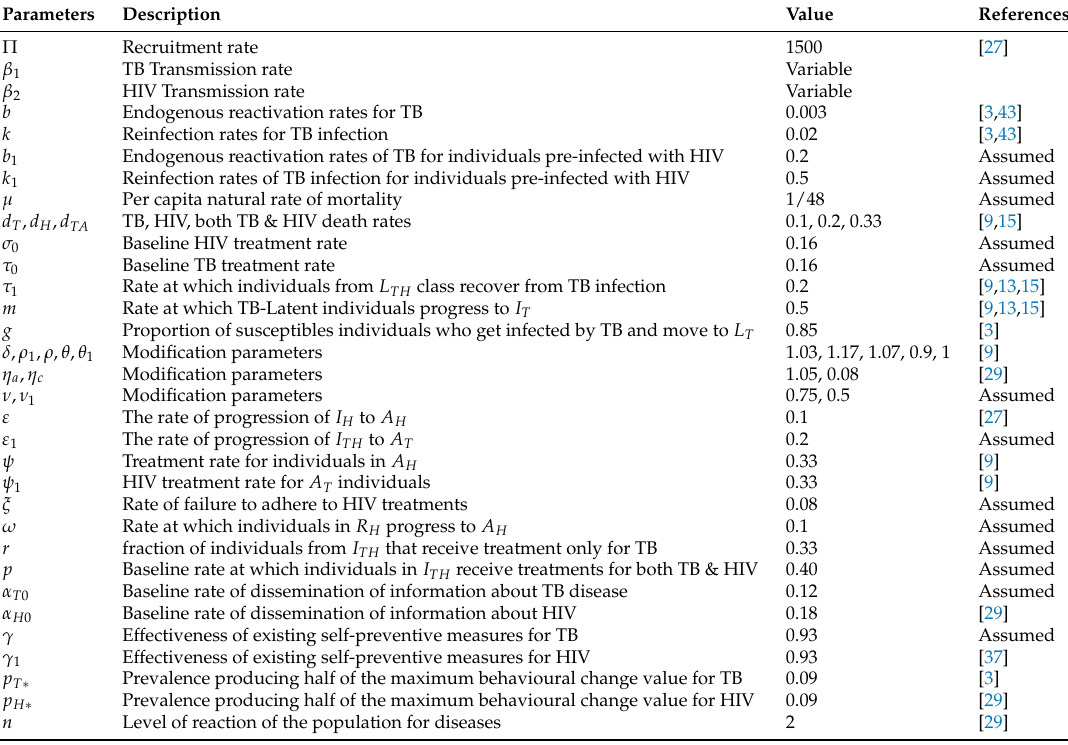
Figure 2. Graphs for the trajectories for the sub-populations in ( a , b ) and the corresponding values for the prevalence in ( c , d ), when no control efforts are applied. In this case, parameter values β 1 = 1.5 and β 2 = 0.36 are used and the rest of the parameters are as in Table 2. Table 2. Symbols and Description of